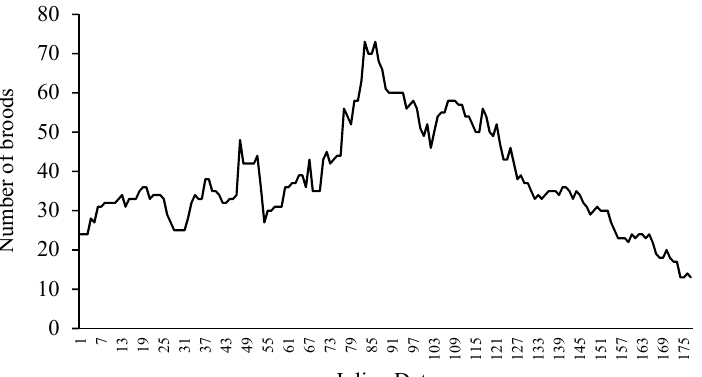
of leaves for their own foraging, and when guarding young, they increase leaf turning frequency to provide foraging opportunities for their young [8].